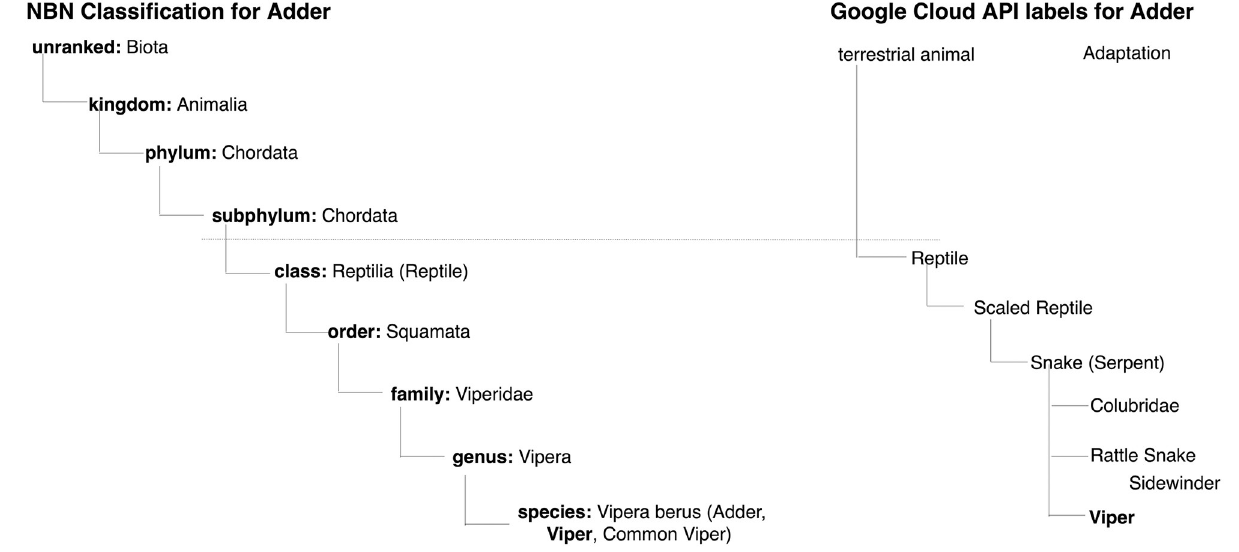
Fig 3. Google Cloud Vision API label taxonomy and NBN classification for